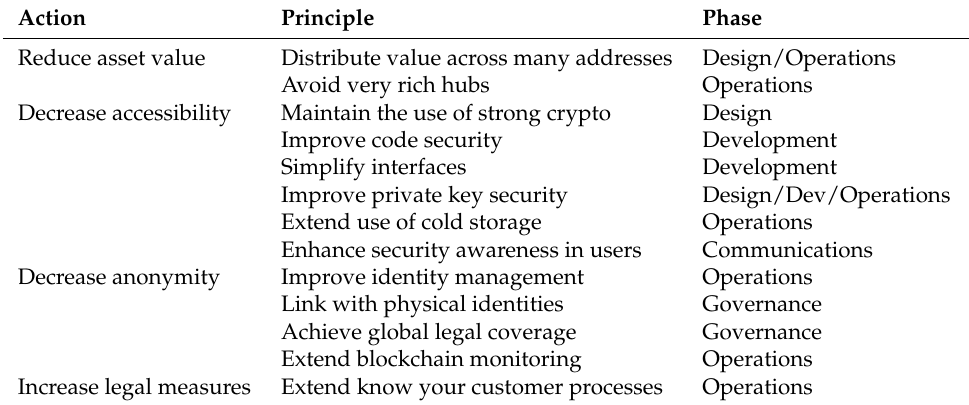
Table 9. Measures to increase intentional risk